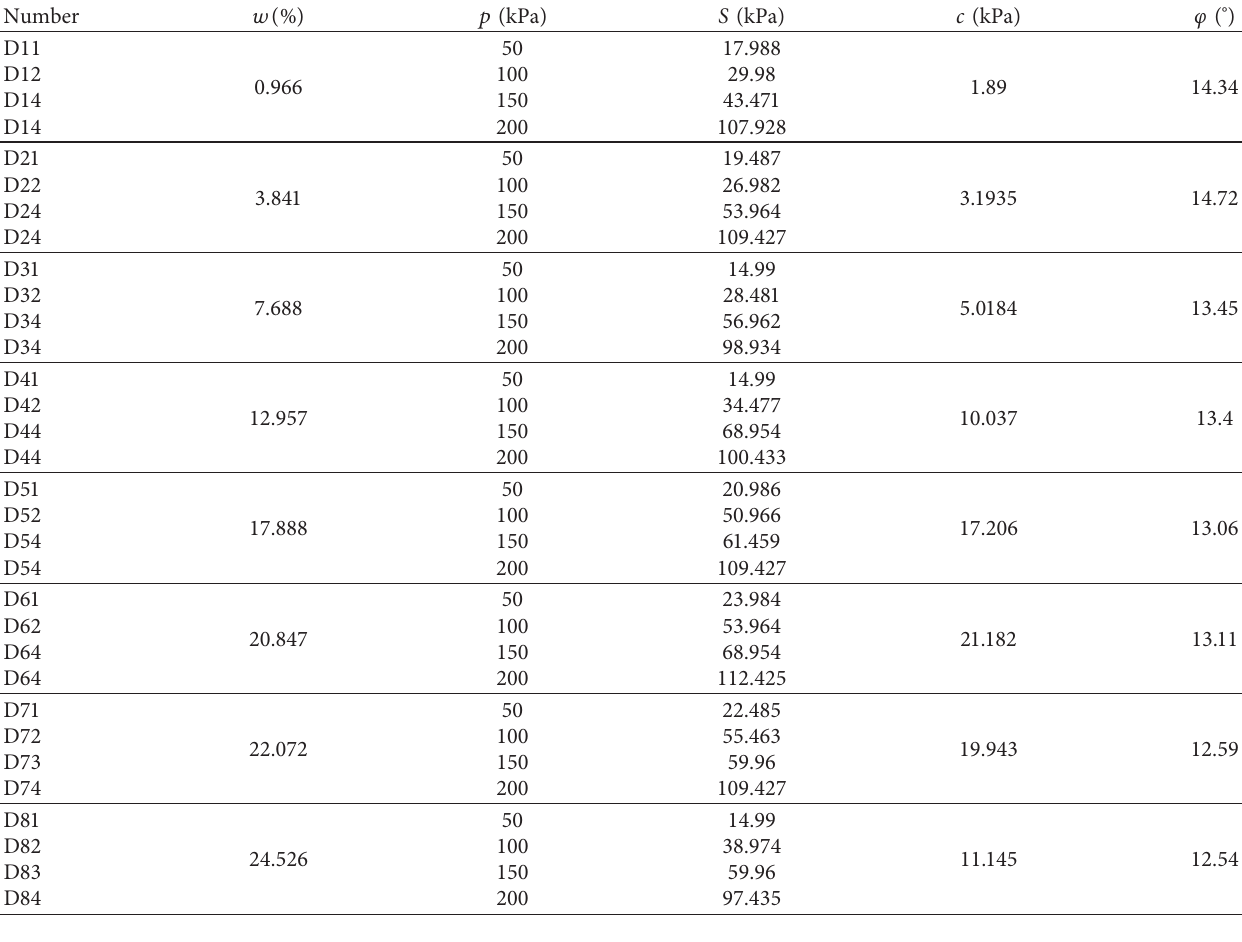
Table 4: Coal shear strength index under different water contents.